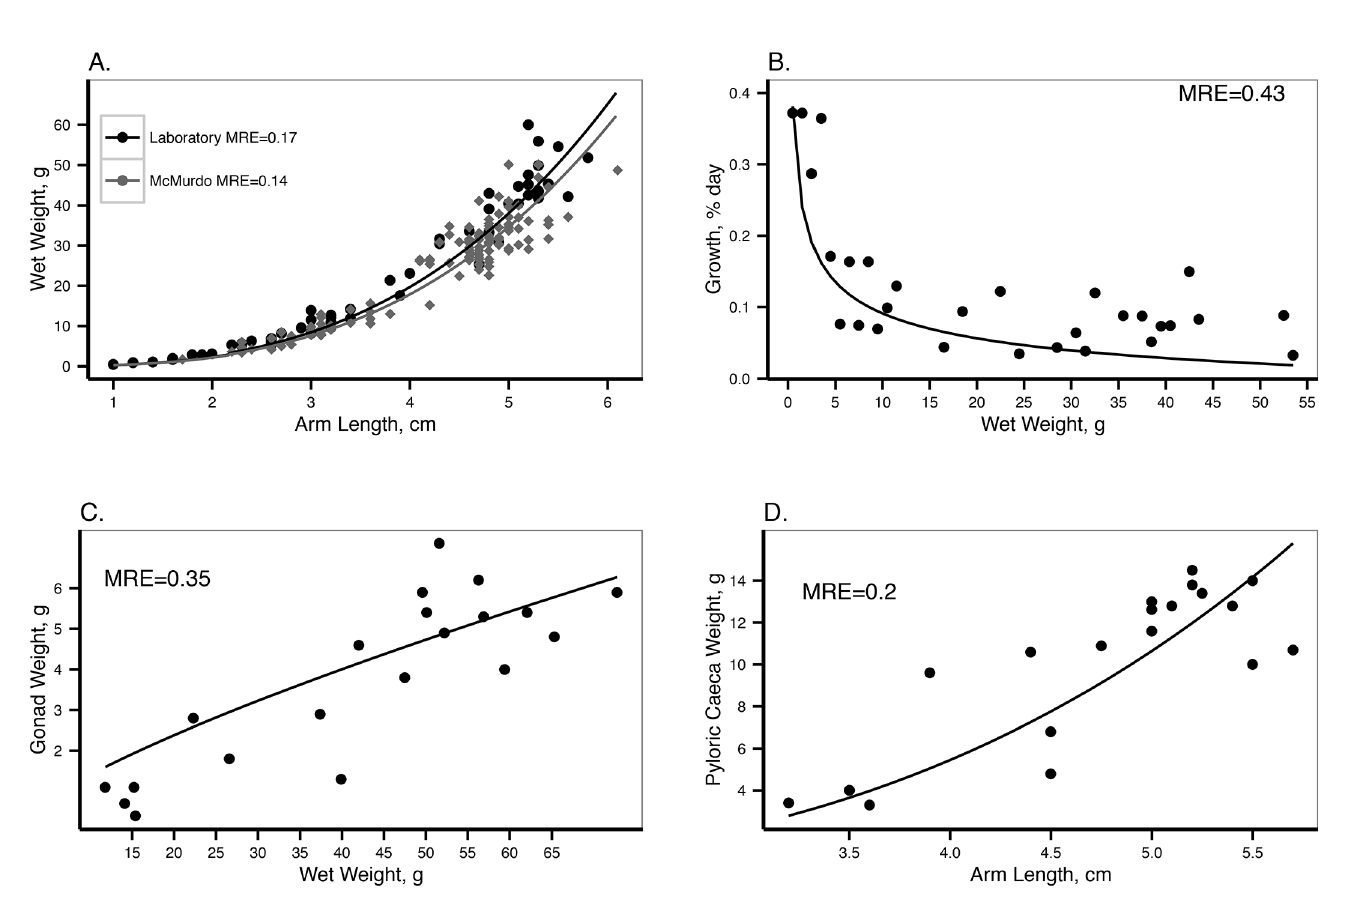
Fig 4. DEB model output with the data on post-metamorphic individuals used for parameter estimation. A. Length-weight relationship, dots are data from laboratory experiments, fed ad libitum (Pearse et al. unpublished data ), diamonds are values from McMurdo station at the same time of the year [23]. B. Proportional growth rate by day according to size. Dots are data from laboratory experiments, animals fed ad libitum [23]. C. Maximum gonad weight according to size. Dots are observed data from laboratory experiments, animals fed ad libitum (Pearse et al. unpublished data ). Maximum gonad size is reached before reproduction takes places around June in McMurdo [12]. D. Pyloric caeca weight according to size. Dots are observed data from laboratory experiments after being fed ad libitum for more than a year (Pearse et al. unpublished data ). MRE is the mean absolute relative